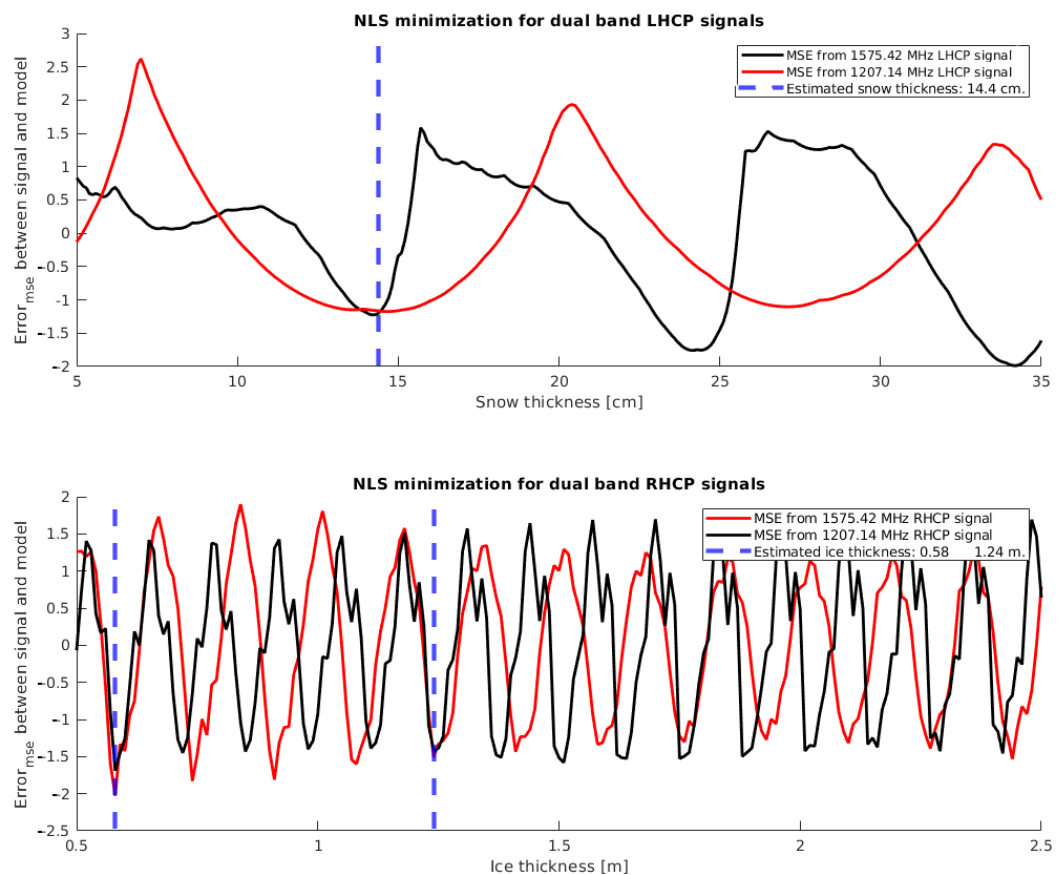
Figure 12. NLS minimization output for the data set between the 15th and the 27th of January 2020. MSE is represented for both snow and ice thickness, for di ff erent signal frequencies and polarization, and it has been normalized (z-score normalization) to ease its visualization. Note that the exact place where both signals present a minimum at the same thickness is represented by the blue dashed line thickness and the ice thickness have an impact on the notch positions; therefore, it is very advisable to first retrieve the snow thickness. As in the LHCP case, the signal is mainly sensitive to the snow.